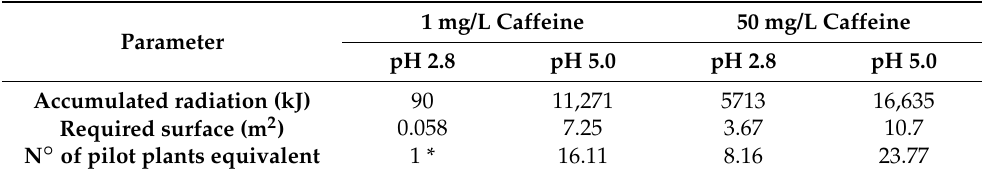
Table 5. The accumulated radiation, the required surface and the corresponding number of equivalent pilot plants, necessary for caffeine degradation. (*) Even if a smaller plant would be sufficient, it was decided to keep the value of 1 pilot plant in the